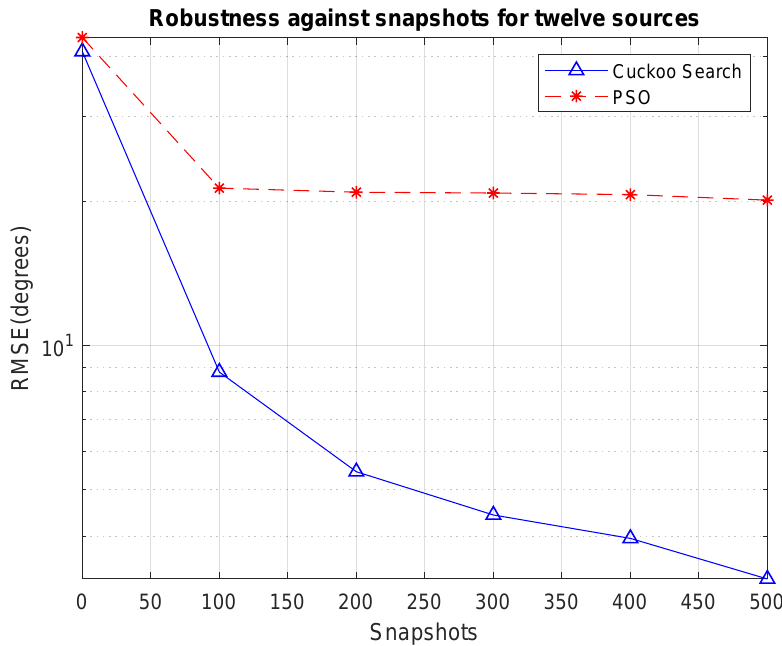
Figure 9. Estimation of robustness using twelve sources in terms of